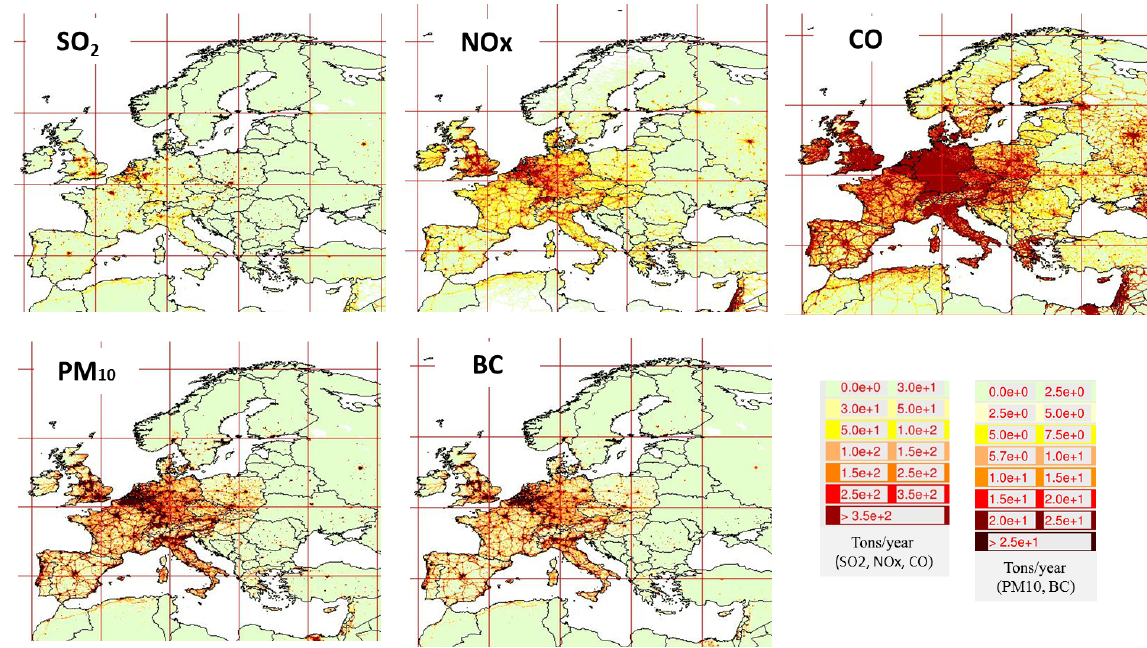
Figure 9. Hotspots of avoided emissions due to progressive implementation of air pollution policy and better technology in Europe: difference of STAG_TECH and REF emissions in 2010 (tyr − 1 (0.1 ◦ × 0.1 ◦ gridcell) − 1 )